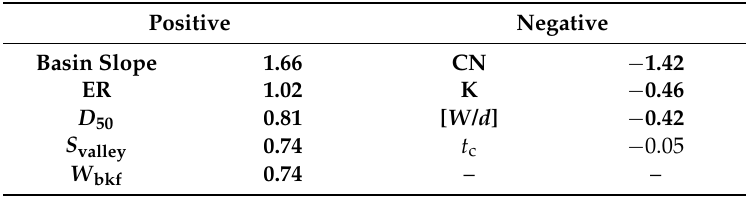
Figure 6. Total Number of Dominant EPT Taxa for urban (% Impervious ě 10) vs. rural (% Impervious Figure 6 . Total Number of Dominant EPT Taxa for urban (% Impervious ≥ 10) vs. rural (% Impervious < 10) Streams ( n = 79). < 10) Streams ( n = 79). Table 8. Coefficients or weights for each morphology and watershed factor resulting from ridge regression following variable